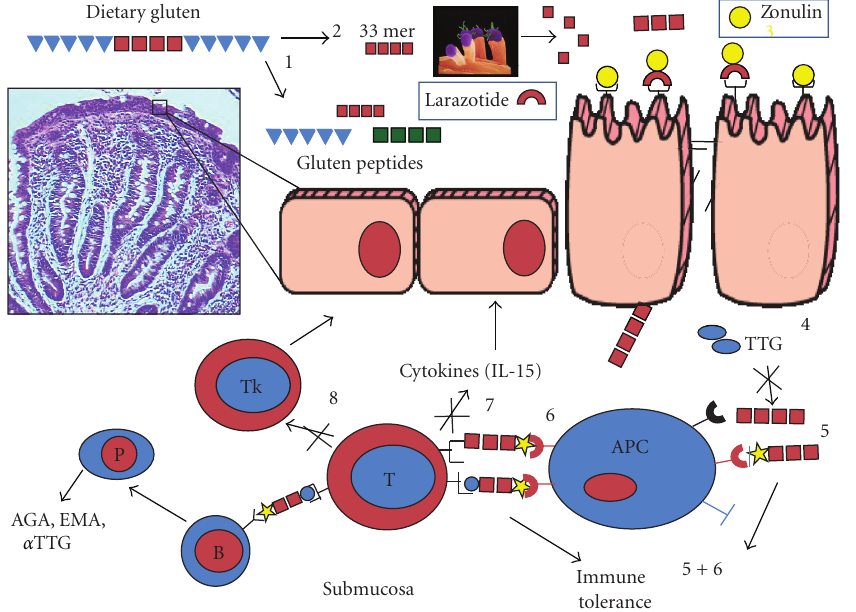
Figure 1: Schematic representation of intestinal mucosal events involved in celiac disease